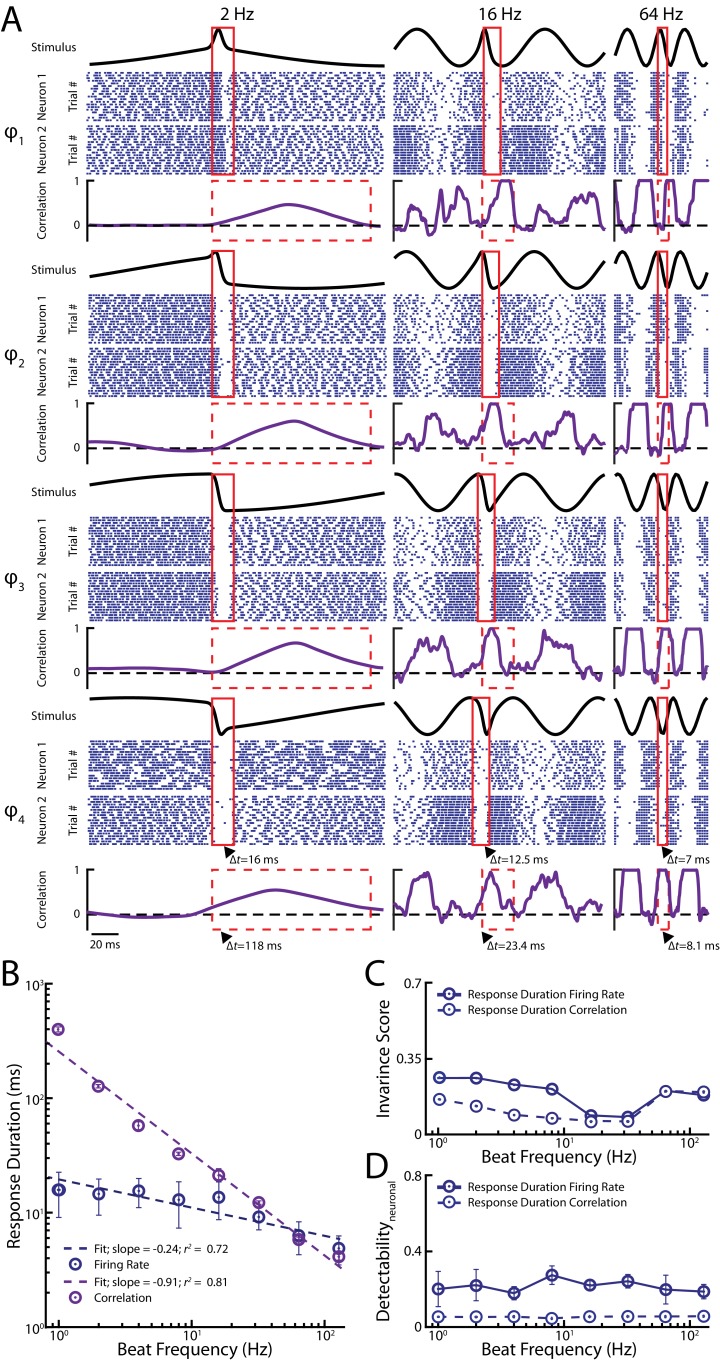
Responses to small chirps occurring on top of beats with varying frequencies.(A) Raster plots of two example afferent responses (blue) and their correlated activity (purple) to chirps occurring at different phases for background beat frequencies of 2 Hz (left), 16 Hz (middle) and 64 Hz (right). The red boxes indicate the response duration for single unit firing rates and correlated activity, respectively, after chirp onset for each chirp-beat combination shown. Note that the remaining four chirp phases are mirror images of the examples shown. (B) Duration of single neuron spiking activity (blue) and of correlated activity (purple) in response to a chirp as a function of background beat frequency. Also shown are the best power paw fits with exponents and R2 values (C) Invariance scores for single unit firing rate using a window size computed from the response duration of primary afferents to chirps (filled) and from the response duration of correlated activity to chirps (hollow). (D) Detectability of chirp waveforms over the beat frequencies for population-averaged firing rate responses using a window whose size was taken from the response duration of primary afferents (filled) and from the response duration of correlated activity (hollow).DOI:
http://dx.doi.org/10.7554/eLife.24482.006
10.7554/eLife.24482.007Figure 2—figure supplement 1—source data 1.Source data for Figure 2—figure supplement 1.